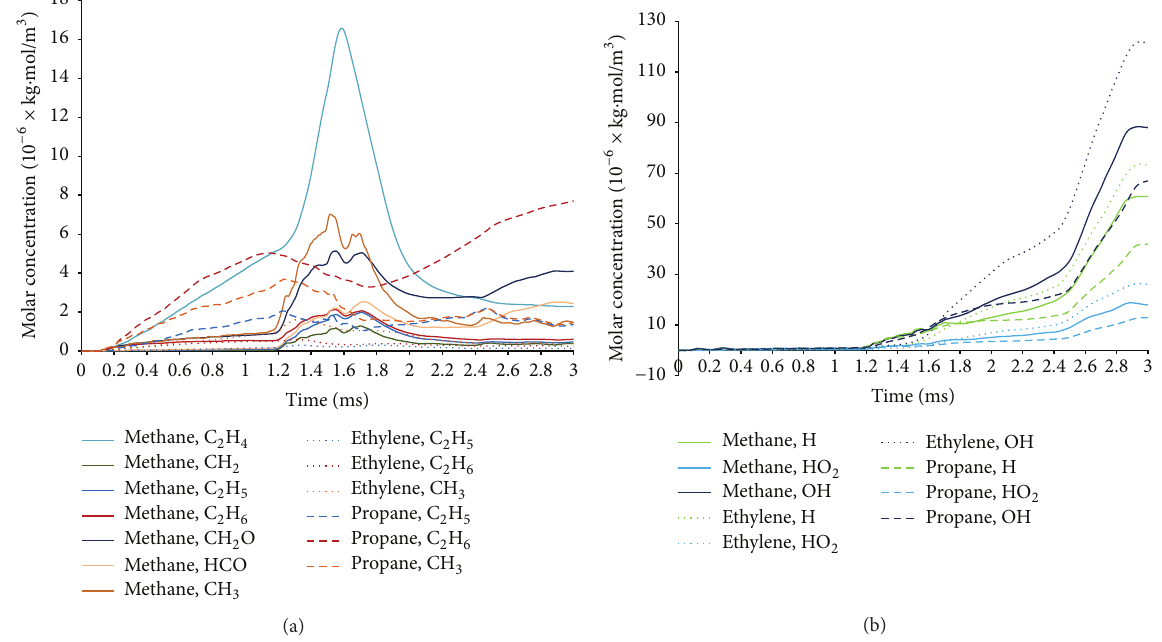
Figure 10: CVC chamber-averaged molar concentrations of intermediate species for different fuel-air